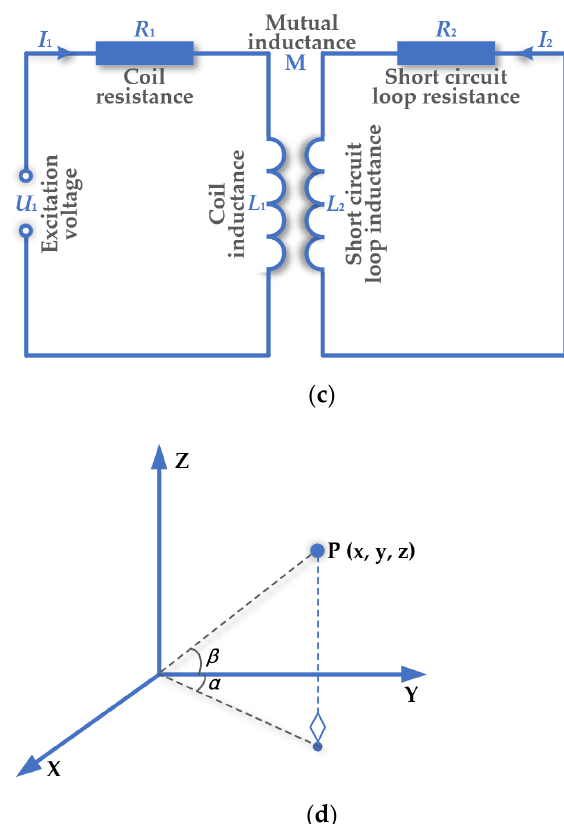
Figure 1. Non ‐ destructive quality monitoring methods of full ‐ size prefabrication and monitoring of Figure 1. Non-destructive quality monitoring methods of full-size prefabrication and monitoring of bridge components for “Pile ‐ Column Integration: ( a ) study framework; ( b ) the rebound test area of bridge components for “Pile-Column Integration: ( a ) study framework; ( b ) the rebound test area of prefabricated concrete components for “Pile ‐ Column Integration”; ( c ) schematic diagram of eddy prefabricated concrete components for “Pile-Column Integration”; ( c ) schematic diagram of eddy current equivalent circuit; ( d ) the principle diagram of point position calculation. current equivalent circuit; ( d ) the principle diagram of point position